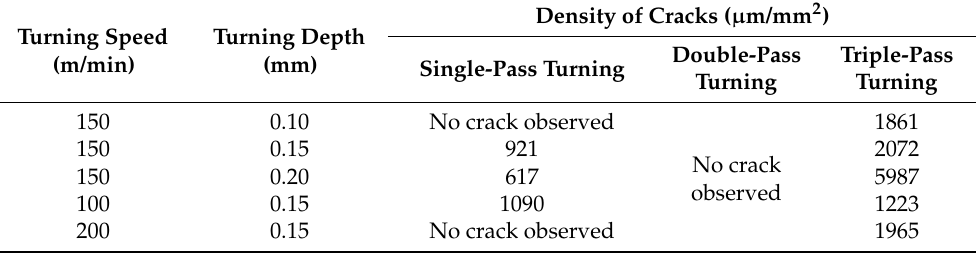
Table 4. The observed crack density of multi-pass